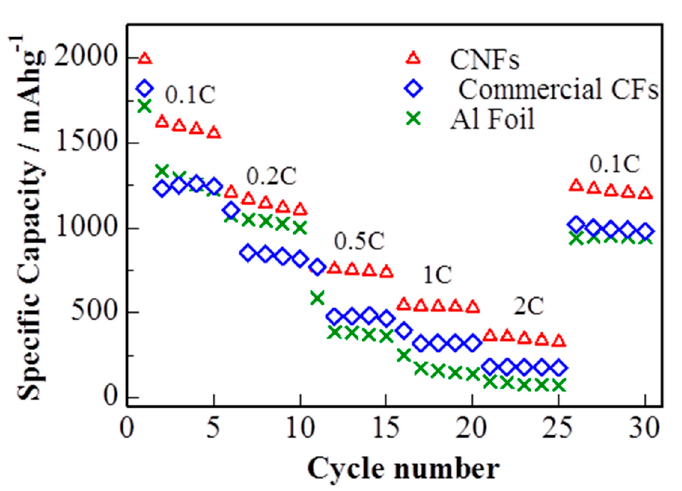
Figure 6. Rate capability of cells with sulfur composite cathode on cPAN CNF, commercial CNF current collector and Al foil (discharge capacity).